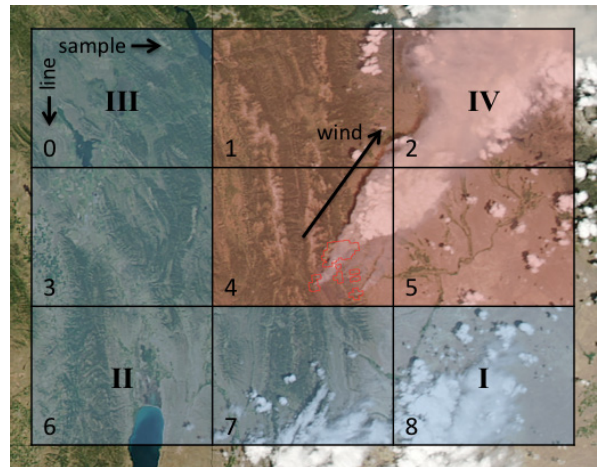
Figure 2. Spatial configuration of a 3 × 3 aerosol-pixel matrix lay- out, whose central pixel contains fires, showing the four downwind pixels (shaded red, quadrant IV) classified as having smoke, and the five remaining upwind pixels (shaded blue) constituting the back- ground. The downwind quadrant is determined by the wind direc- tion. The pixel indices (0–8) shown in their bottom left-hand cor- ners are defined by their scanning configuration, signified here by the directions of line and sample coordinates. The sample direction is along-scan and the line direction is along-track. (The background image taken by Aqua/MODIS at 20:45UTC on 1 July 2012 shows the Fontenelle Fire in Wyoming,